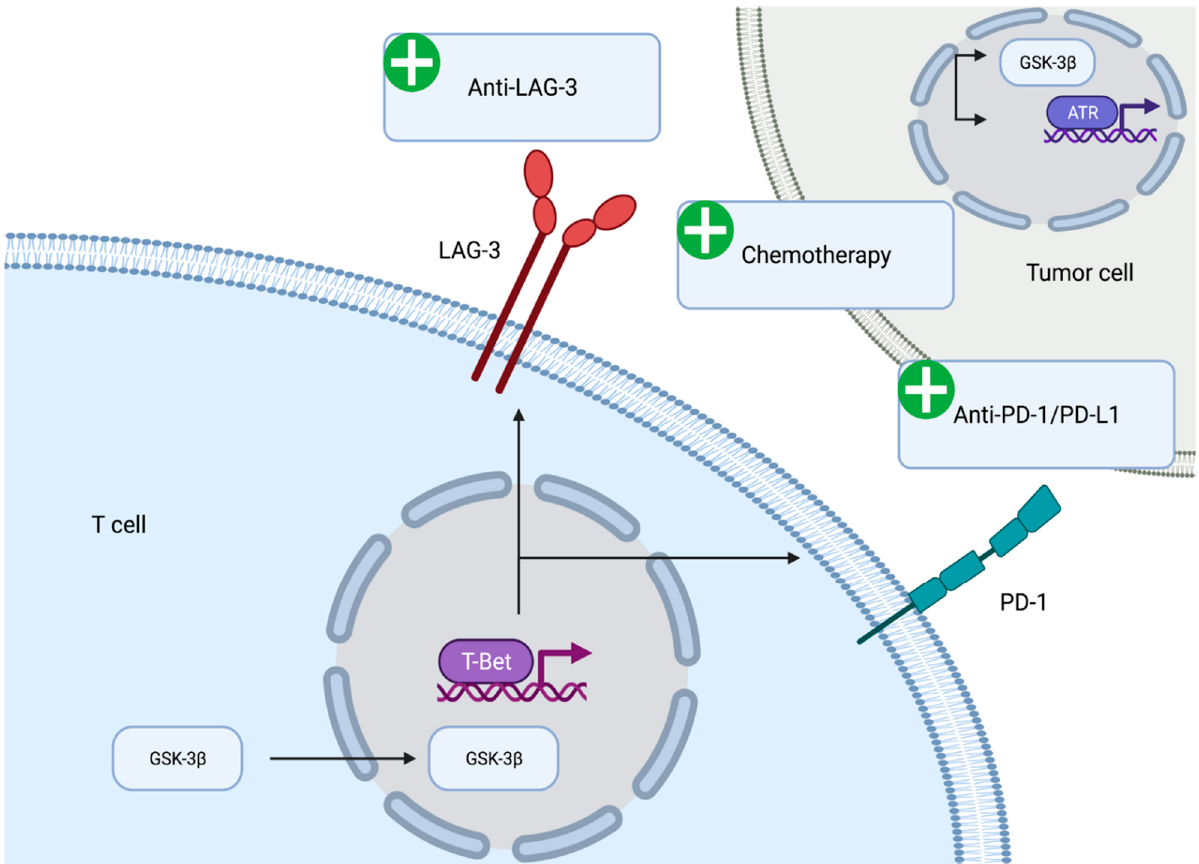
Figure 2. Rationale for combining GSK-3 β inhibitors with immunotherapy and chemotherapy. GSK-3 β increases tumor expression of programmed death ligand-1 (PD-1) and lymphocyte activation gene-3 (LAG-3), both of which can be reversed with small molecule inhibition of GSK-3 β . Furthermore, GSK-3 β inhibition can prevent DNA damage response activation by chemotherapeutic agents such as gemcitabine by preventing the induction of the ATR/TopBP1 pathway. Such mechanisms support a rationale for combining GSK-3 β small molecule inhibitors with chemotherapy and immunotherapy. Created with BioRender.com (accessed on 21 February 2021).